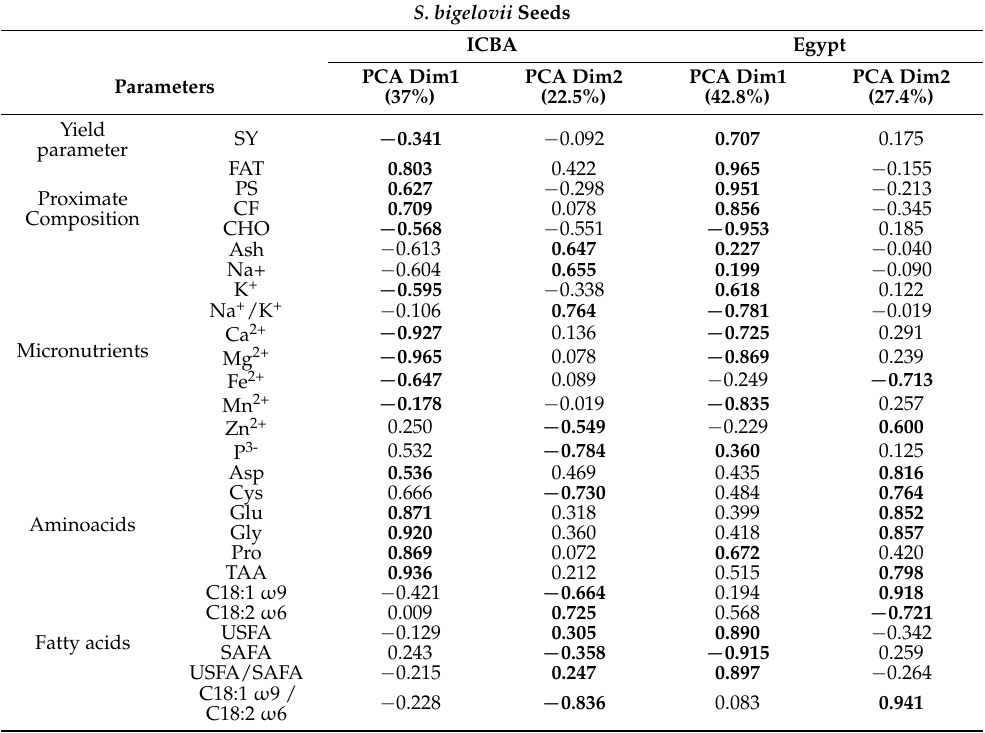
Table A8. Eigenvector values per Principal Component Analysis (PCA) Dimension 1 and 2 (Dim1 and Dim2) of seed yield, proximate composition, micronutrients, amino acids and fatty acids measured for the seeds of all S. bigelovii genotypes after harvest at ICBA in the United Arab Emirates (Figure 5a) and Mubarak Valley in Egypt (Figure 5b). The higher value for each parameter between the two axes is in